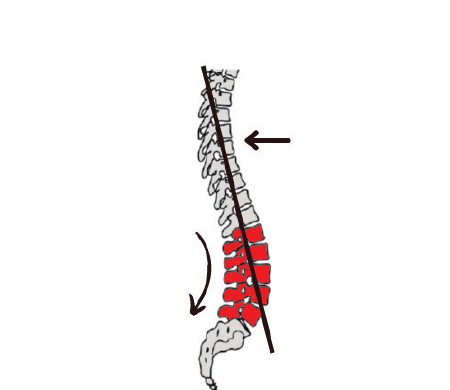
Figure-I: To restore sagittal stability, an adaptive rise